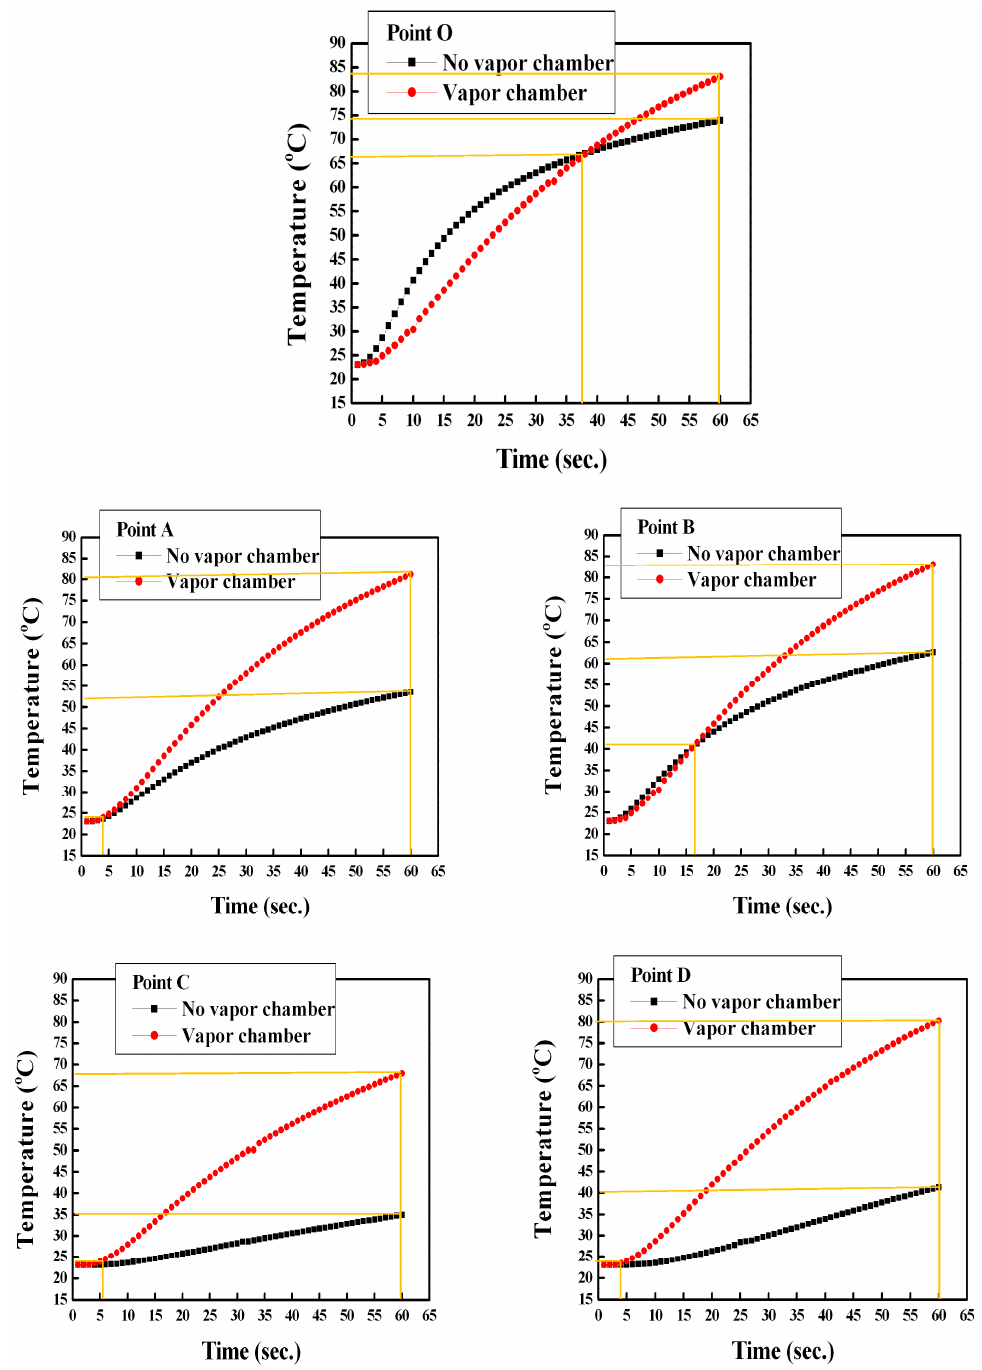
Figure 7. Relations of the temperatures with the heating time with/without vapor chamber.